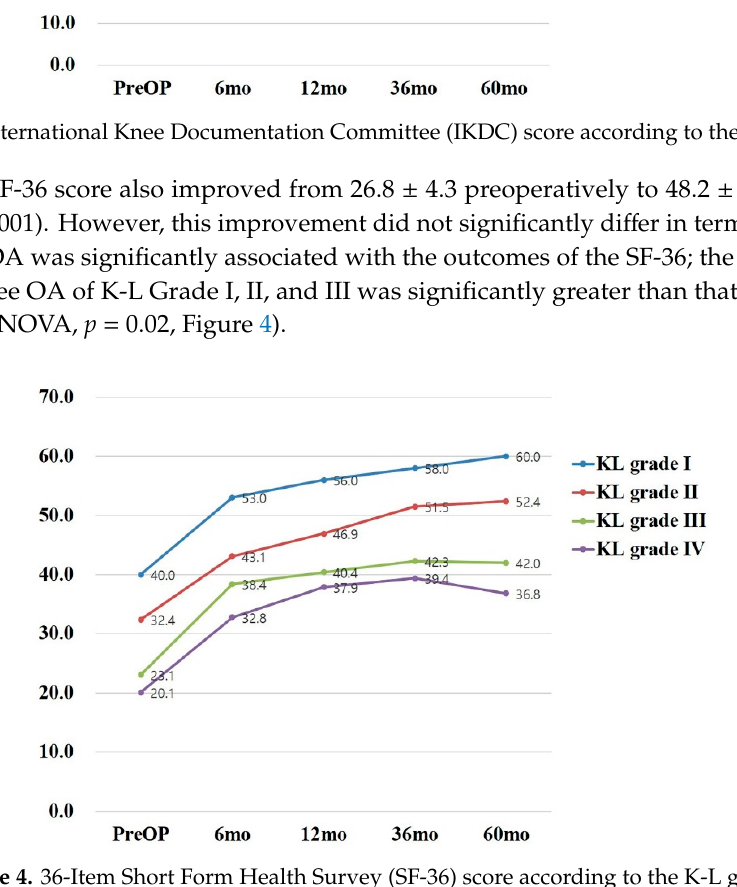
Figure 4. 36-Item Short Form Health Survey (SF-36) score according to the K-L grade.